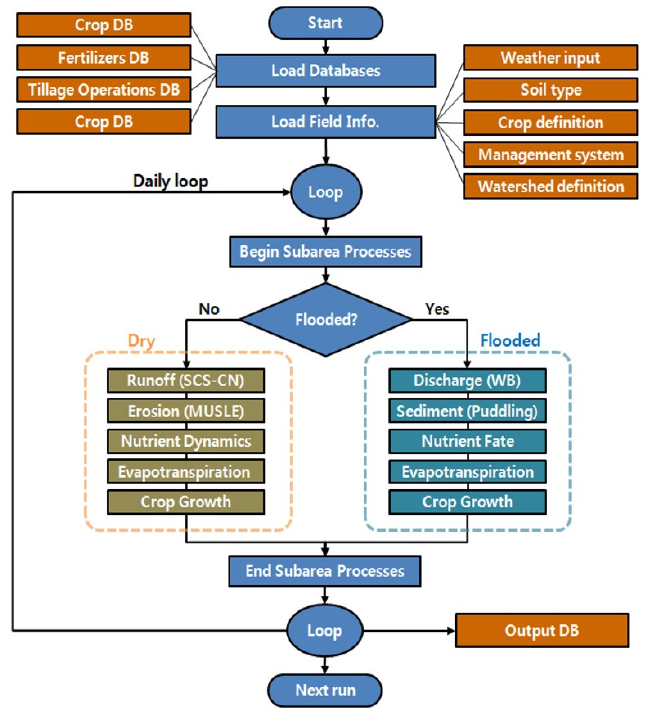
Figure 2. Schematic diagram of the Agricultural Policy/Environmental eXtender(APEX)-Paddy algorithm.